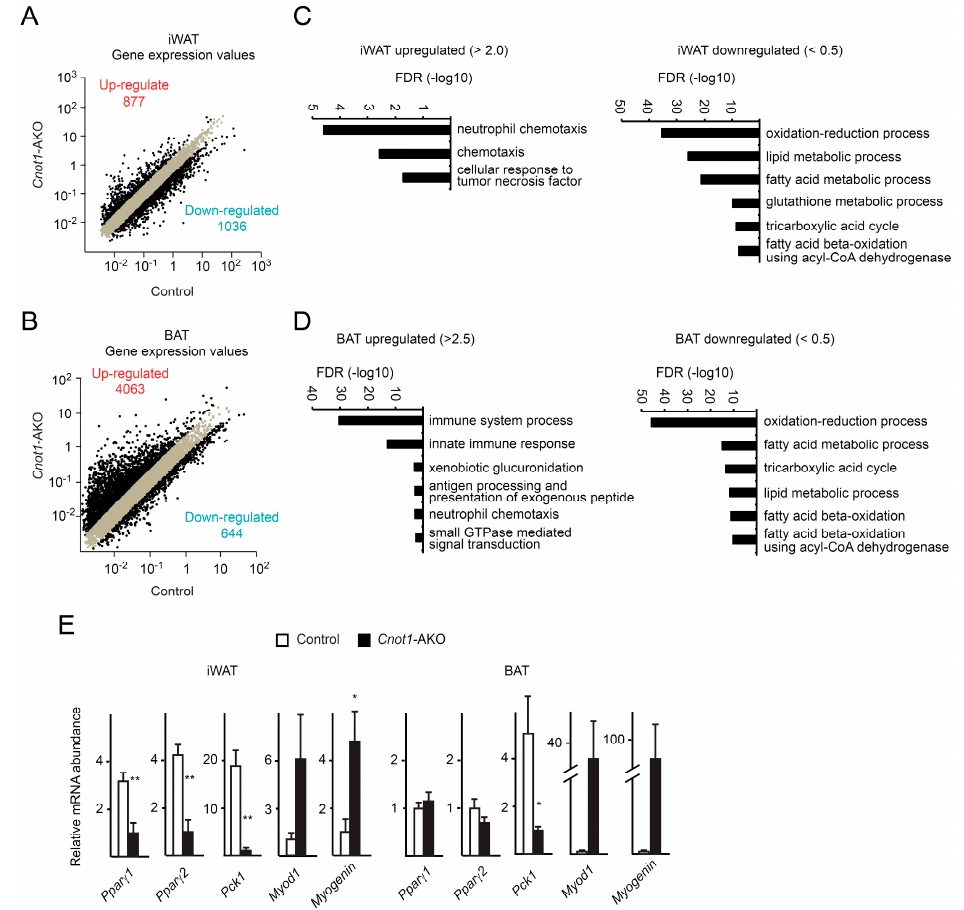
Figure 4. CNOT1 suppression in adipocytes leads to an increase of mRNAs for immunoresponse and a decrease of those for metabolic processes. ( A , B ) Scatter plots of gene expression values in iWAT ( A ) and BAT ( B ) of 12-week-old control and Cnot1 -AKO mice ( n = 4). Black dots represent mRNAs whose expression di ff ered more than two-fold in Cnot1 -AKO mice compared to controls. ( C , D ) (GO) enrichment analysis of mRNAs that were upregulated ( > 2.0 in iWAT and > 2.5 in BAT) or downregulated ( < 0.5) in iWAT ( C ) and BAT ( D ) of 12-week-old Cnot1 -AKO mice. Bar charts of the Biological Process (BP) GO terms (at most six) ranked by the false discovery rate (FDR) ( < 0.05) are shown. Gene lists included in each GO term are summarized in Supplementary Tables S1 and S2. ( E ) Quantitative PCR analysis of the indicated mRNA levels in iWAT and BAT of 12-week-old mice ( n = 4). Values in the graphs represent mean ± sem. * p < 0.05, ** p < 0.01, *** p < 0.001, unpaired t-test.